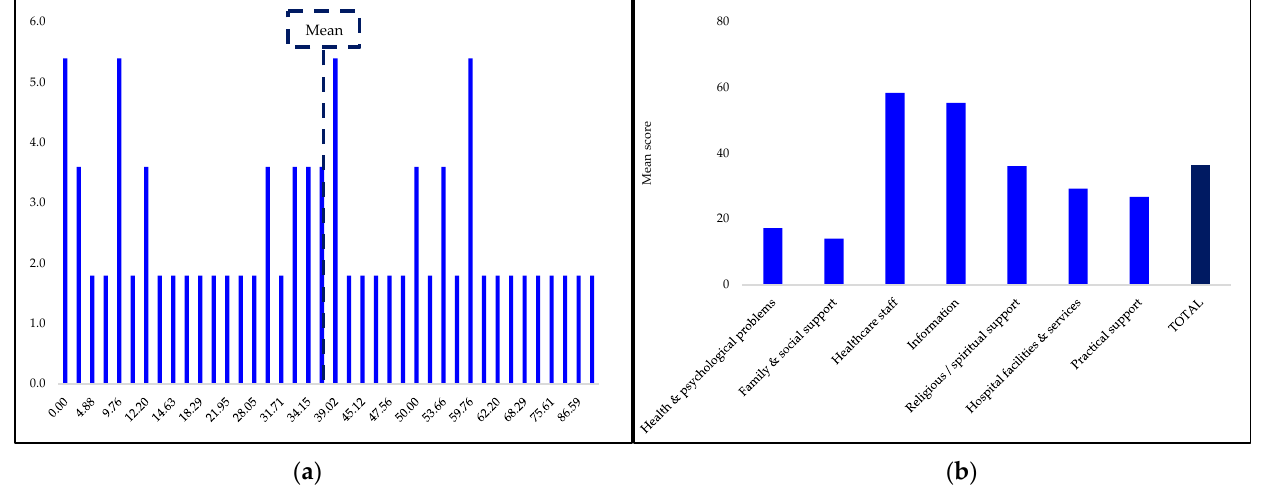
Figure 2. Oral cancer caregivers’ SCN scores. ( a ) Frequency of SCN scores (%); ( b ) M-CNAT-C domains mean scores.